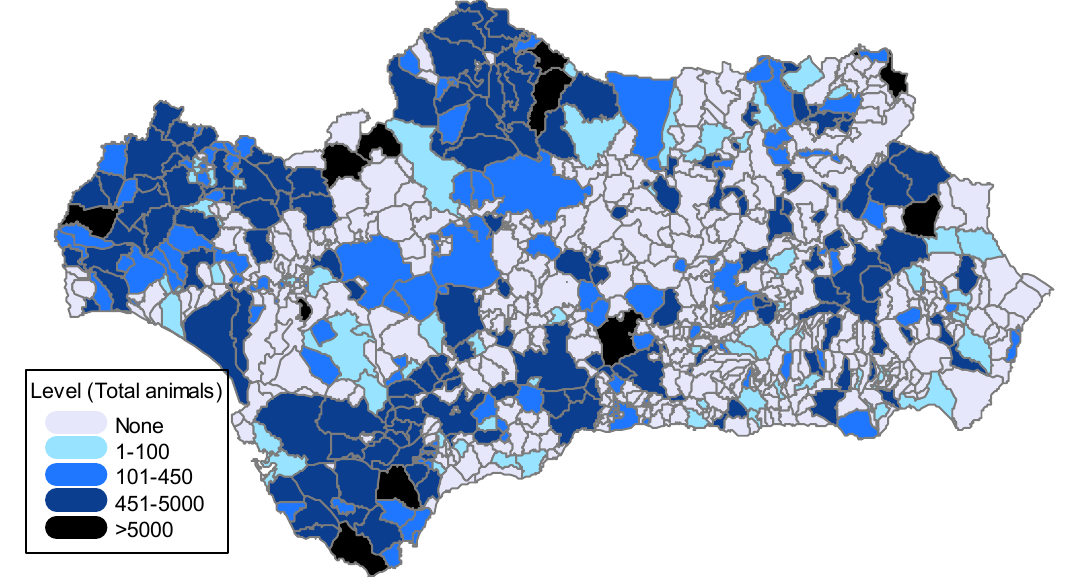
Figure 2. Spatial distribution of total animals in organic livestock farms by municipalities.